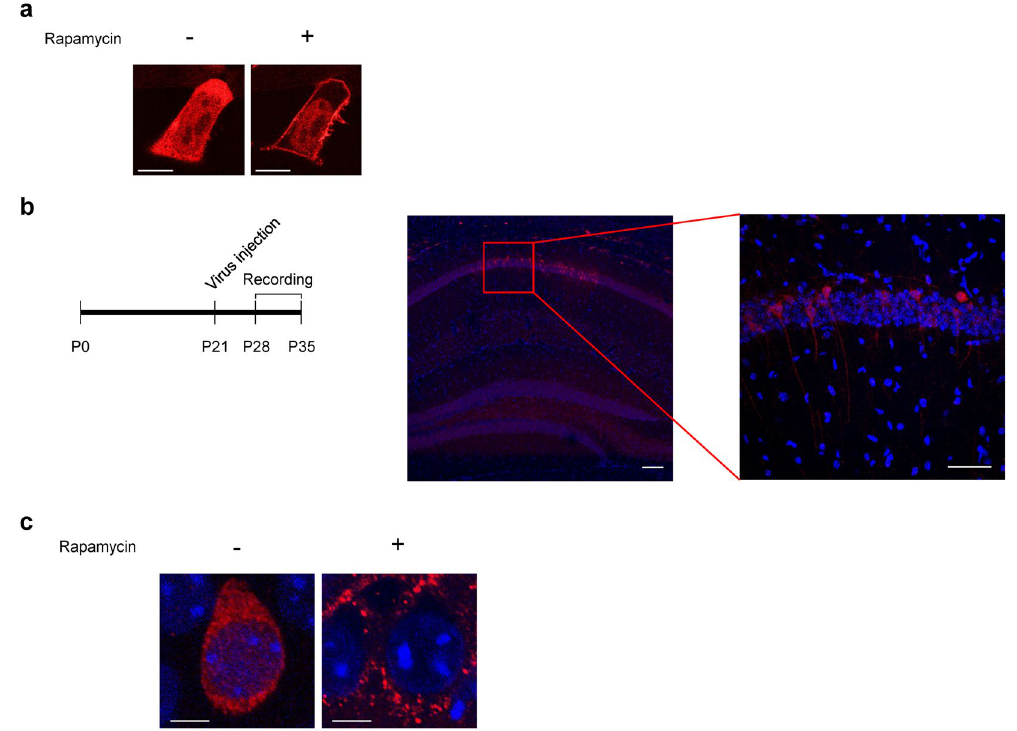
Figure 2. Viral expression of LDR-T2A-Inp54p in HEK293T cells and a mouse brain. ( a ) Example images of a HEK293T cell infected with lentivirus containing the chemically induced PIP 2 depletion system before and after treatment with 100 nM rapamycin. Scale bar: 10 μ m. ( b ) Experimental timeline for virus infusion and electrophysiological analysis (left). Representative images of lentiviral LDR-T2A-Inp54p expression in the mouse hippocampus showing DAPI (blue) and LDR-T2A-Inp54p expression (red) (middle). The magnified image shows the red rectangular area in the middle image (right). Scale bars: 100 μ m (middle) and 50 μ m (right). ( c ) Translocation of FKBP-Inp54p in brain slices with ( + ) and without ( − ) bath application of 100 nM rapamycin. FKBP-Inp54p (red), DAPI (blue) are shown. Scale bars: 5 μ